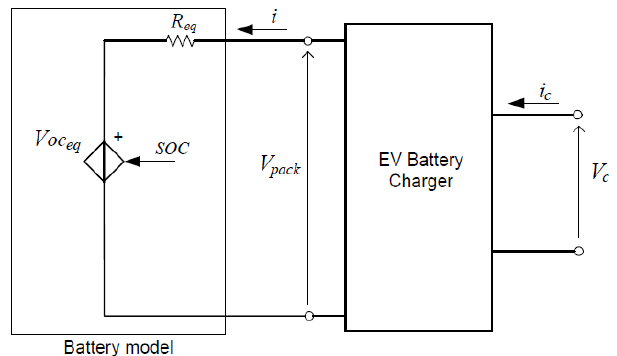
Figure 3. Simple schematic diagram of an EV battery.